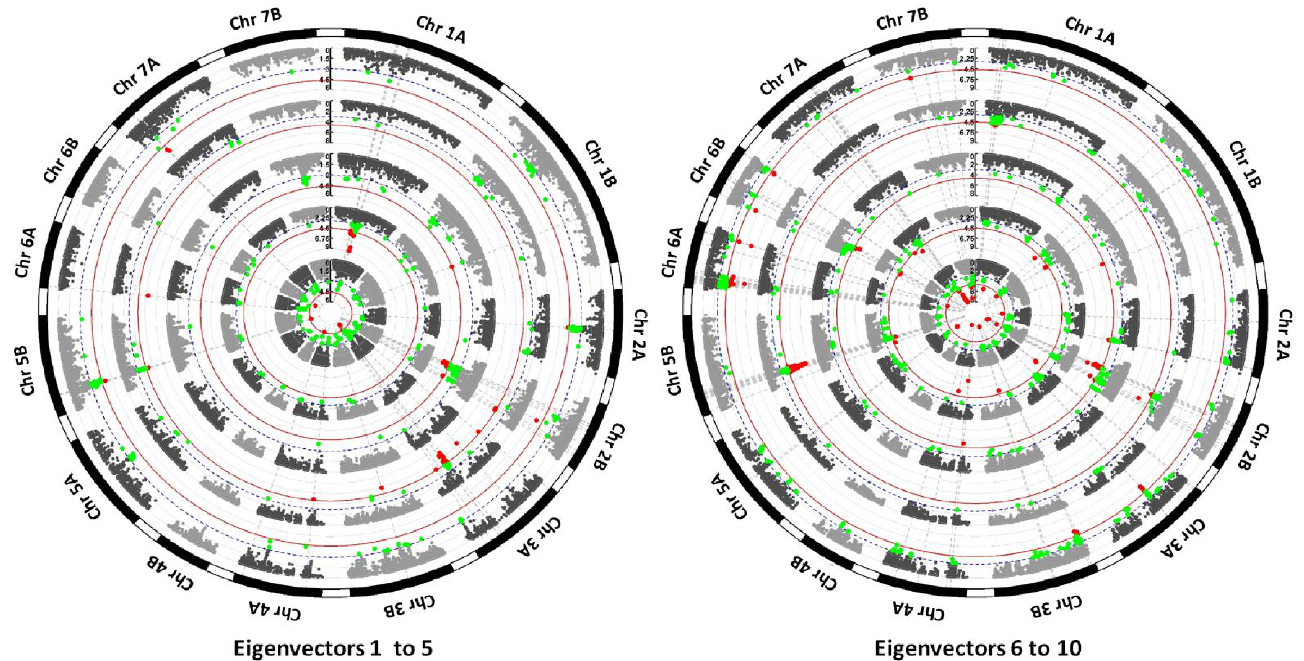
Figure 3. EigenGWAS for the top ten eigenvectors. Left circle: from the inside out, eigenvectors 1 to 5. Right circle: from the inside out, eigenvectors 6 to 10. Green dots correspond to significant marker–trait associations (MTAs) at a moderate threshold (–log 10 p = 3.0, blue dotted line) and red dots correspond to significant MTAs above the false discovery rate (FDR) threshold (–log 10 p = 4.6, red line).